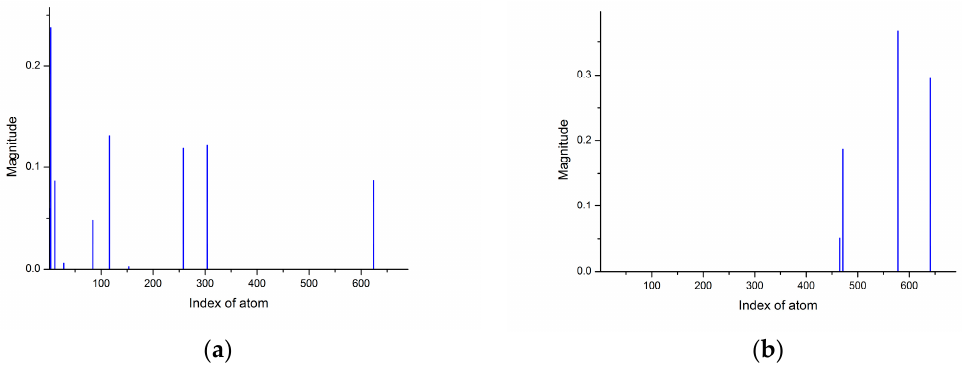
Figure 9. Estimated sparse coefficients for impervious surface and non-impervious surface in the Pavia center image: ( a ) coefficient of pixel (732, 116); and ( b ) coefficient of pixel (290, 462). Table 4. Accuracy assessment for Pavia center image.